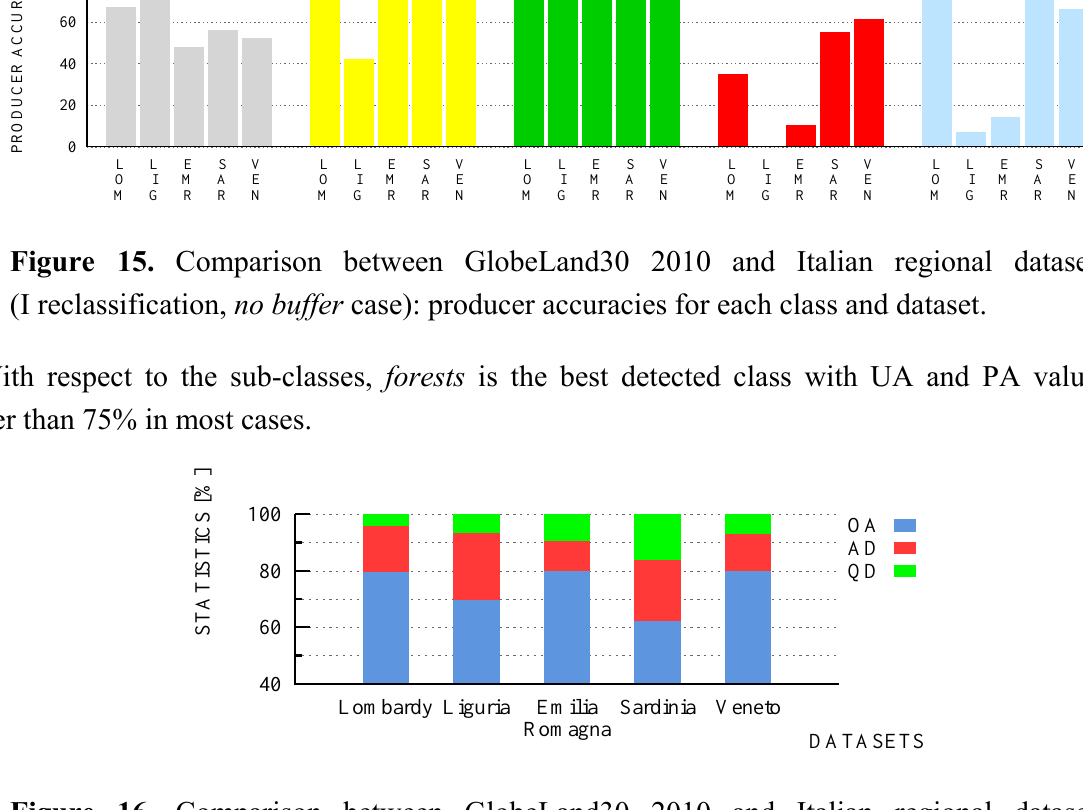
Figure 16. Comparison between GlobeLand30 2010 and Italian regional datasets (II reclassification, no buffer case): overall accuracy (OA), allocation disagreement (AD), quantity disagreement (QD) for each regional